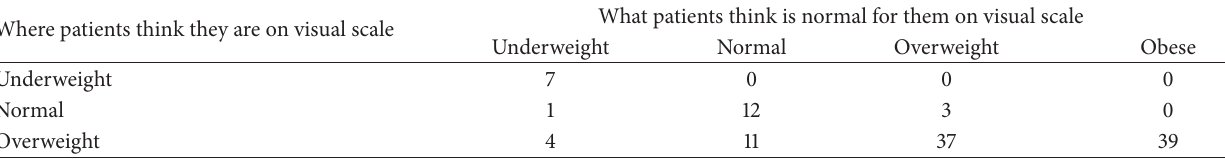
Table 6: Patients perception of where they are on the visual scale and what is normal for them on the visual scale. What patients think is normal for them on visual scale Where patients think they are on visual scale Underweight Normal Overweight Obese Underweight 7 0 0 0 Normal 1 12 3 0 Overweight 4 11 37 39 Fisher’s exact test 𝑃 value <